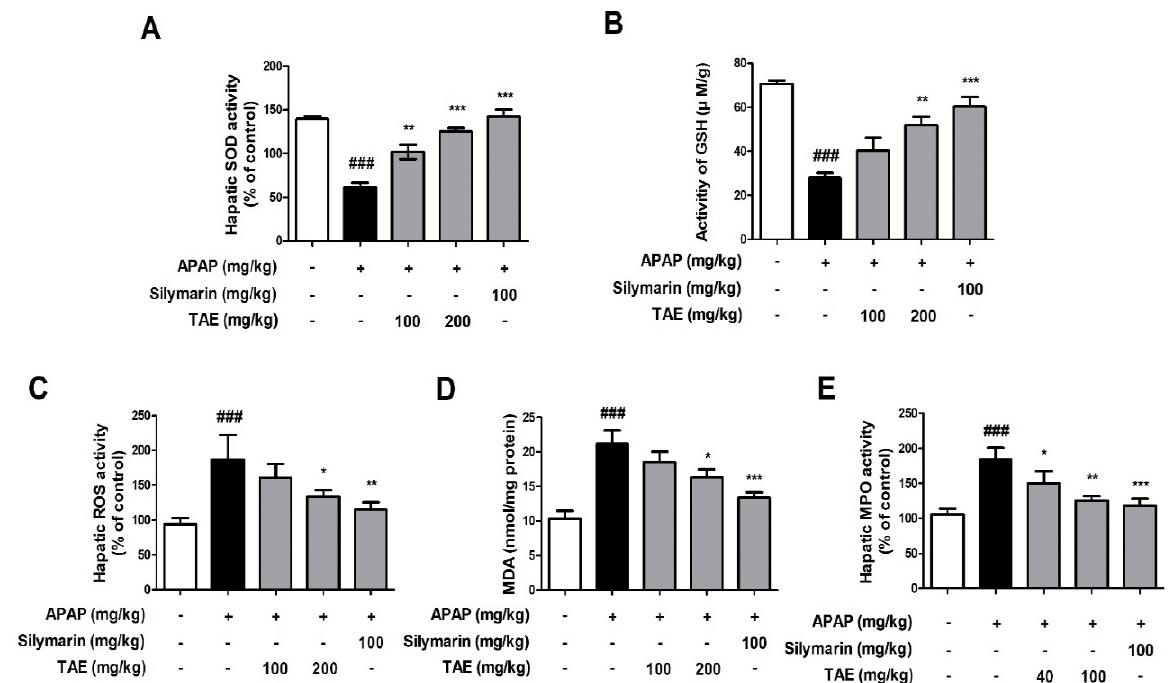
Figure 3. Effect of ethanolic Triticum aestivum sprout extract on N -acetyl-para-aminophenol (APAP)-induced liver oxidative stress in mice livers. ( A ) SOD activity. ( B ) GSH activity. ( C ) ROS activity. ( D ) MDA activity. ( E ) MPO activity. All data are shown as mean ± SD. ### p < 0.001 versus Normal group; * p < 0.05, ** p < 0.01, and *** p < 0.001 versus APAP group. APAP, N -acetyl-para-aminophenol (acetaminophen); GSH, glutathione; MDA, malondialdehyde; MPO, myeloperoxidase; ROS, reactive oxygen species; SOD, superoxide dismutase; TAE, Triticum aestivum sprouts extract.